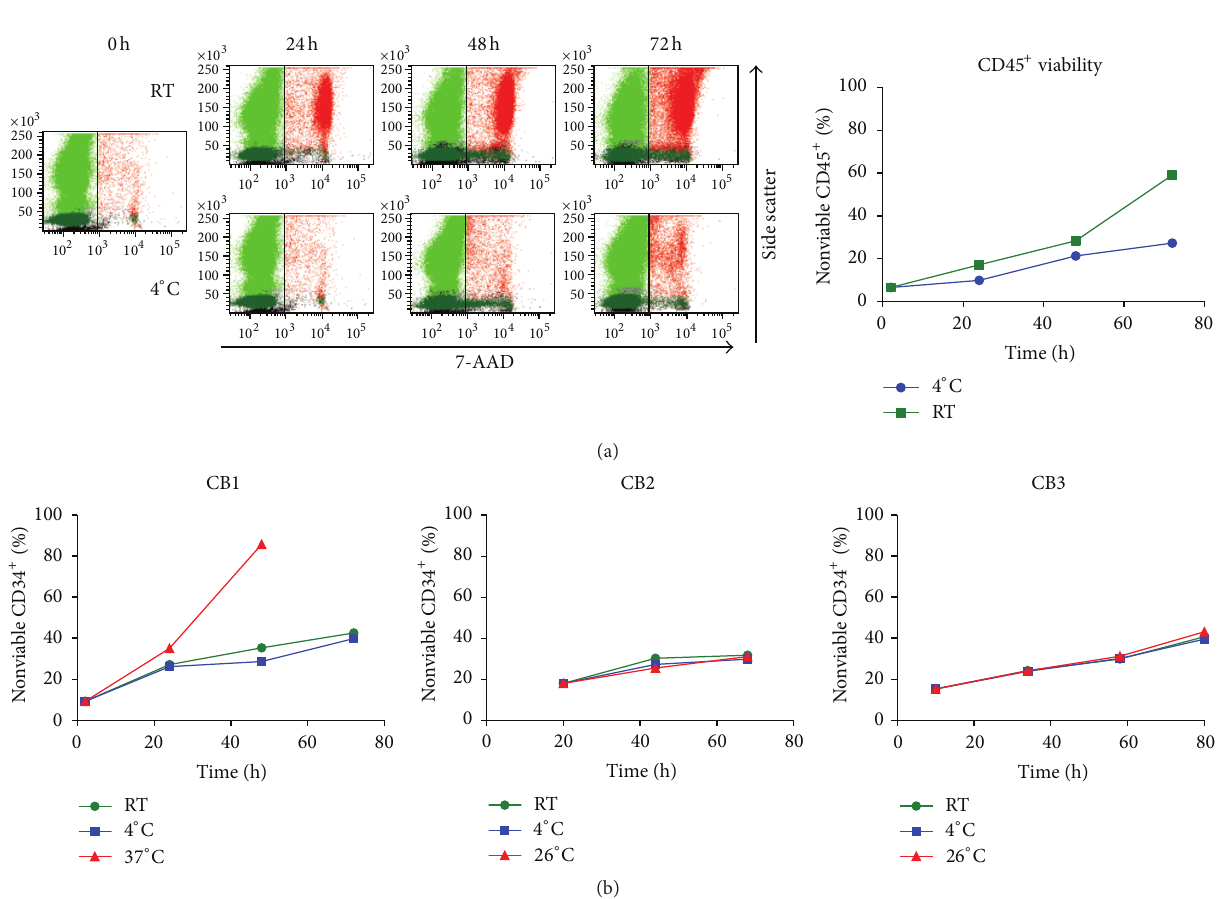
Figure 6: (a) Total leukocytes showed lower viability when stored at room temperature in comparison to 4 ∘ C. (b) Regarding CD3 4 + cells, results revealed no difference between storage at 4 ∘ C, room temperature and 26 ∘ C; only storage at 37 ∘ C did drastically increase amount of nonviable cells (exemplarily shown in CB1; red triangles), making the according samples unsuitable for flow cytometric analysis after more than 60